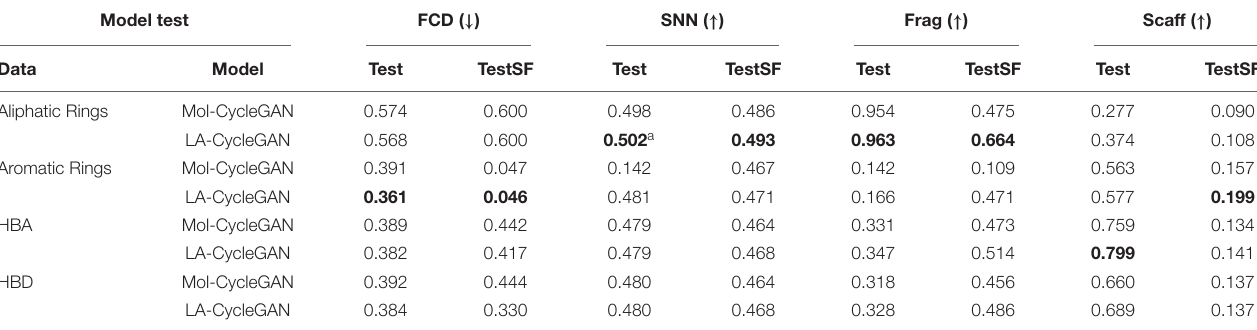
a The bolded data in Table 5 represents the best value for the column.